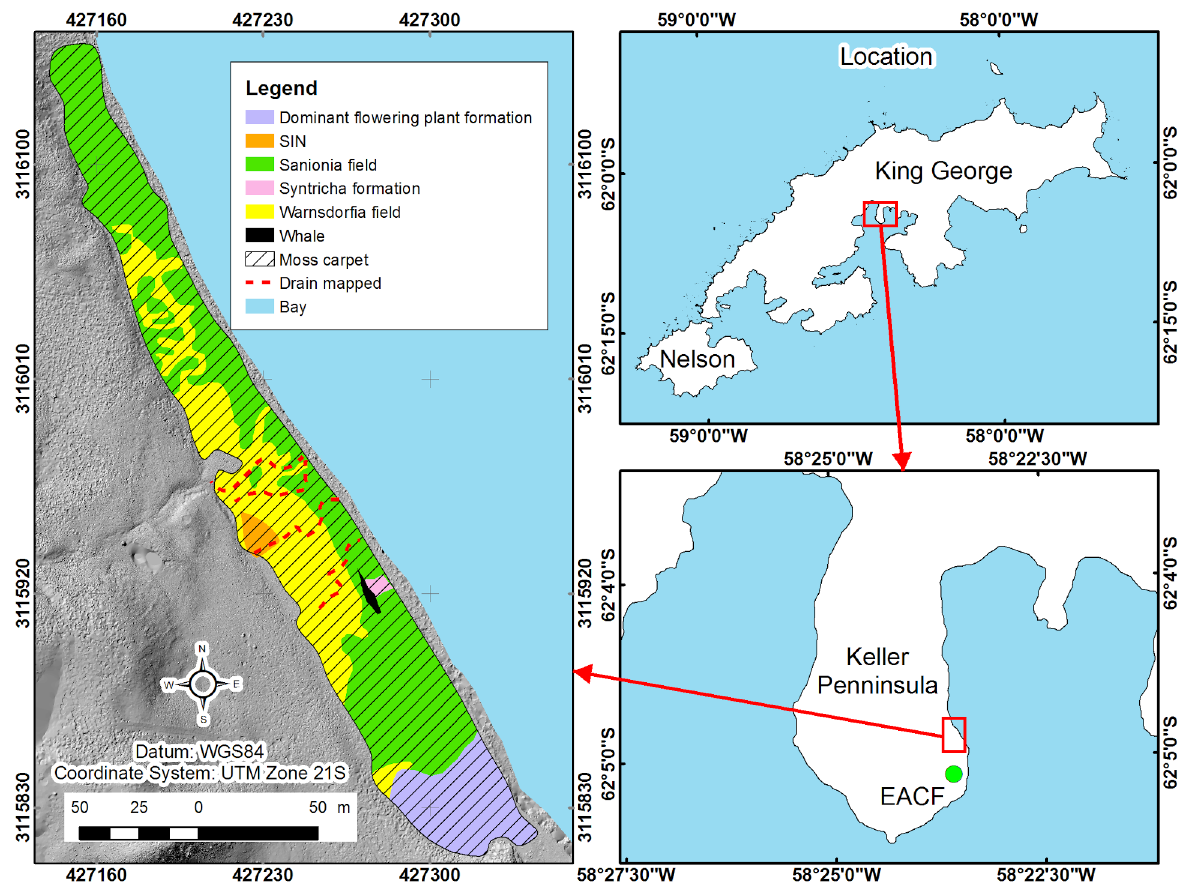
Figure 4. Schematic map showing the plant distribution in the studied